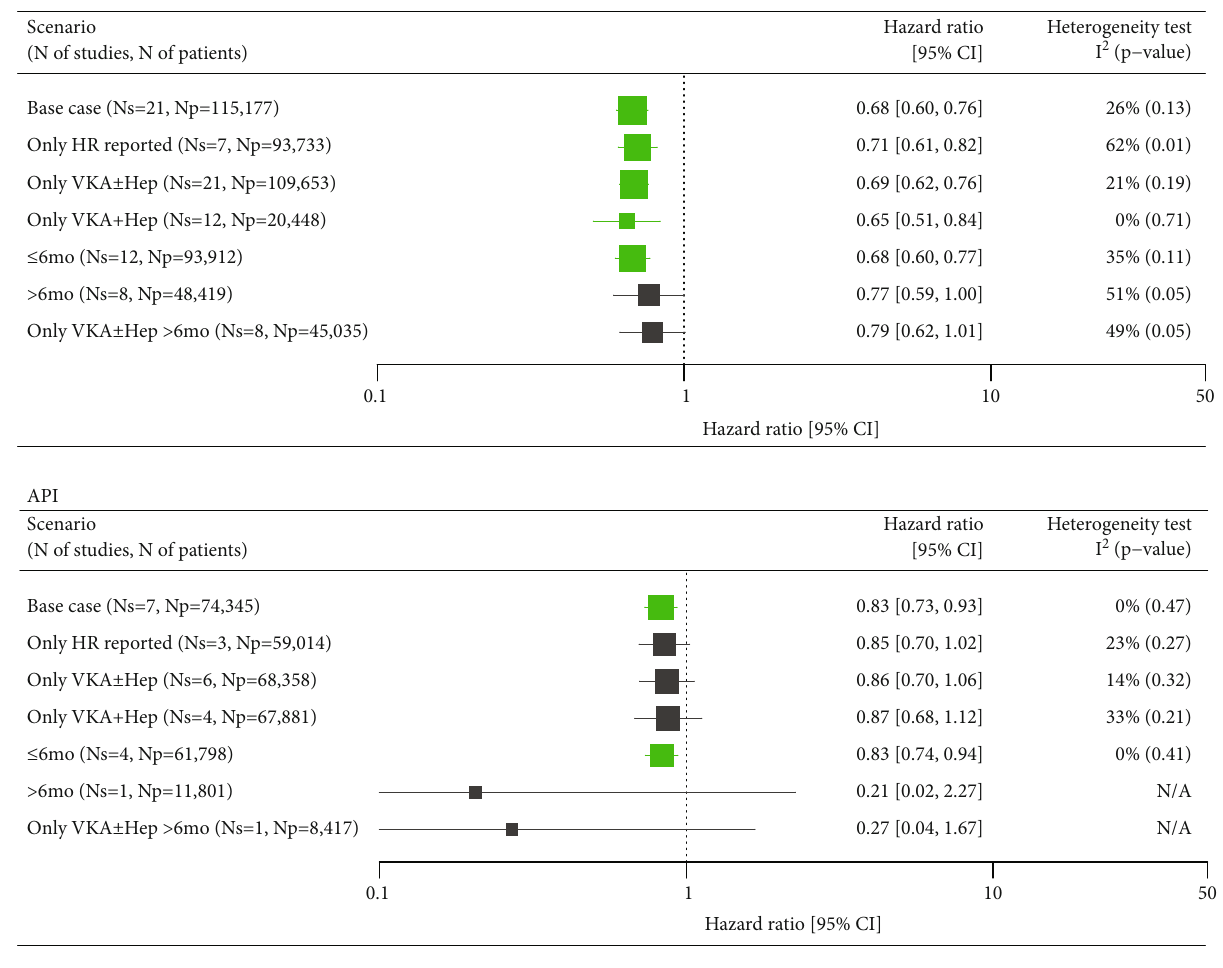
Figure 1: Summary of meta-analyses comparing RIV and API versus SoC in VTE for recurrent VTE. API: apixaban; CI: con fi dence interval; HR: hazard ratio; Np: number of patients; Ns: number of studies; RIV: rivaroxaban; SoC: standard of care; VKA ± Hep: vitamin K antagonist ± heparins; VTE: venous thromboembolism; N/A: not applicable. Green marks represent results indicating statistically lower event rate in the NOAC